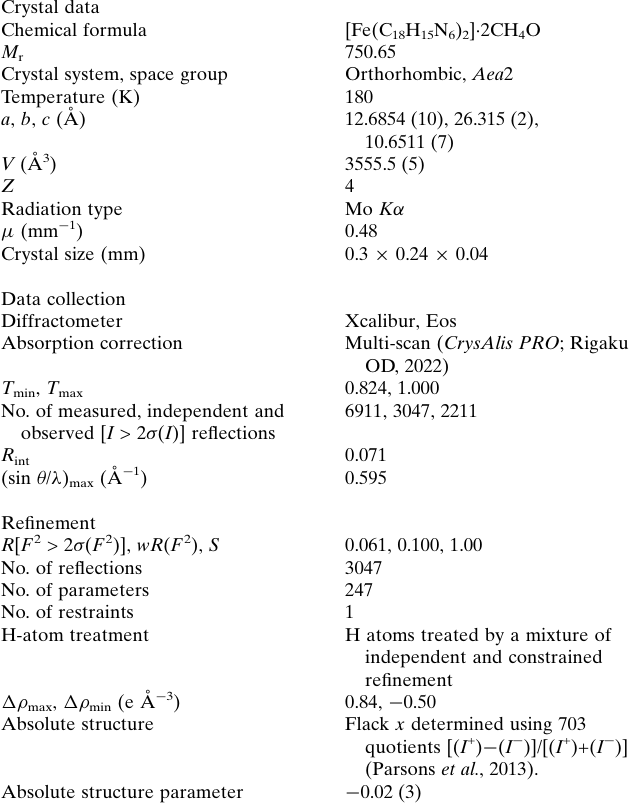
Table 3 Experimental details. Crystal data Chemical